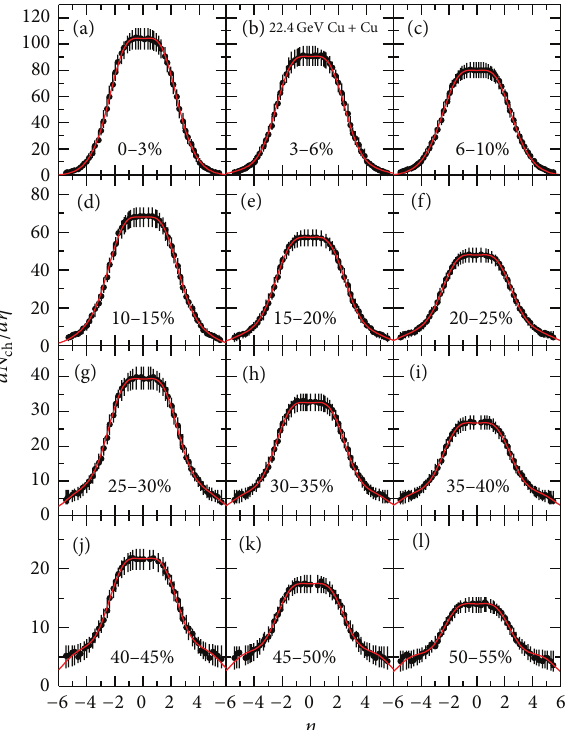
Figure 3: As Figure 1 but showing the results in Au-Au collisions at √𝑠 = 130 GeV. 𝑁𝑁